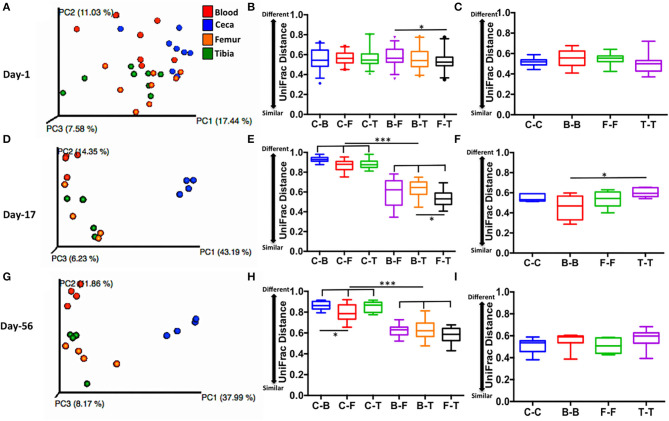
Level of similarity between sites measured by unweighted UniFrac distance. (A,D,G) PCoA plots of sites at days 1, 17, and 56 respectively. (B,E,H) Inter-site unweighted UniFrac distance at days 1,17, and 56, respectively. (C,F,I) Intra-site unweighted UniFrac distance at days 1, 17, and 56, respectively. UniFrac distance is based on subsampling depth of 600 sequences/sample. Unweighted UniFrac constituted both intra- and inter-subject distance. Boxplot displays median with whisker representing 2.5–97.5 percentile. Data were analyzed by ANOVA and Tukey's multiple-comparison test. Sites: C, ceca; B, blood; F, femur; and T, Tibia. *p < 0.05, ***p < 0.001.